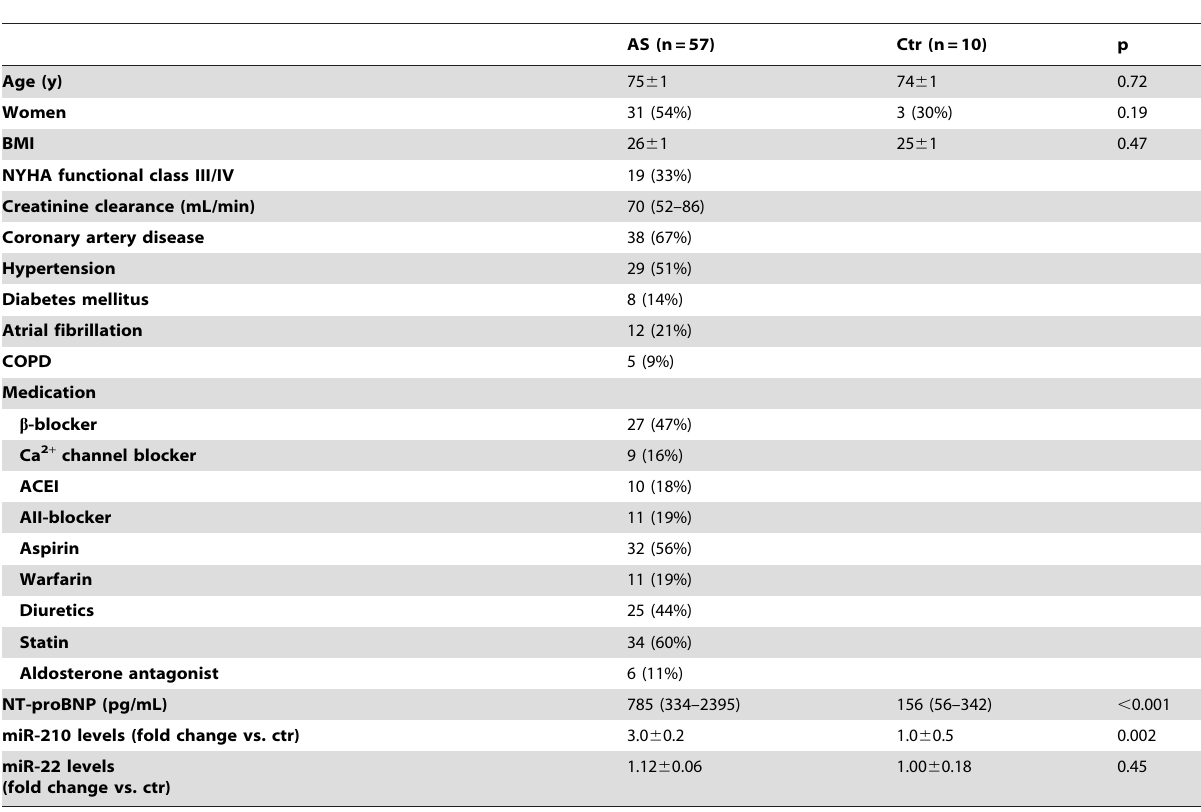
Table 1. Baseline characteristics of the patients with aortic stenosis and the control subjects.